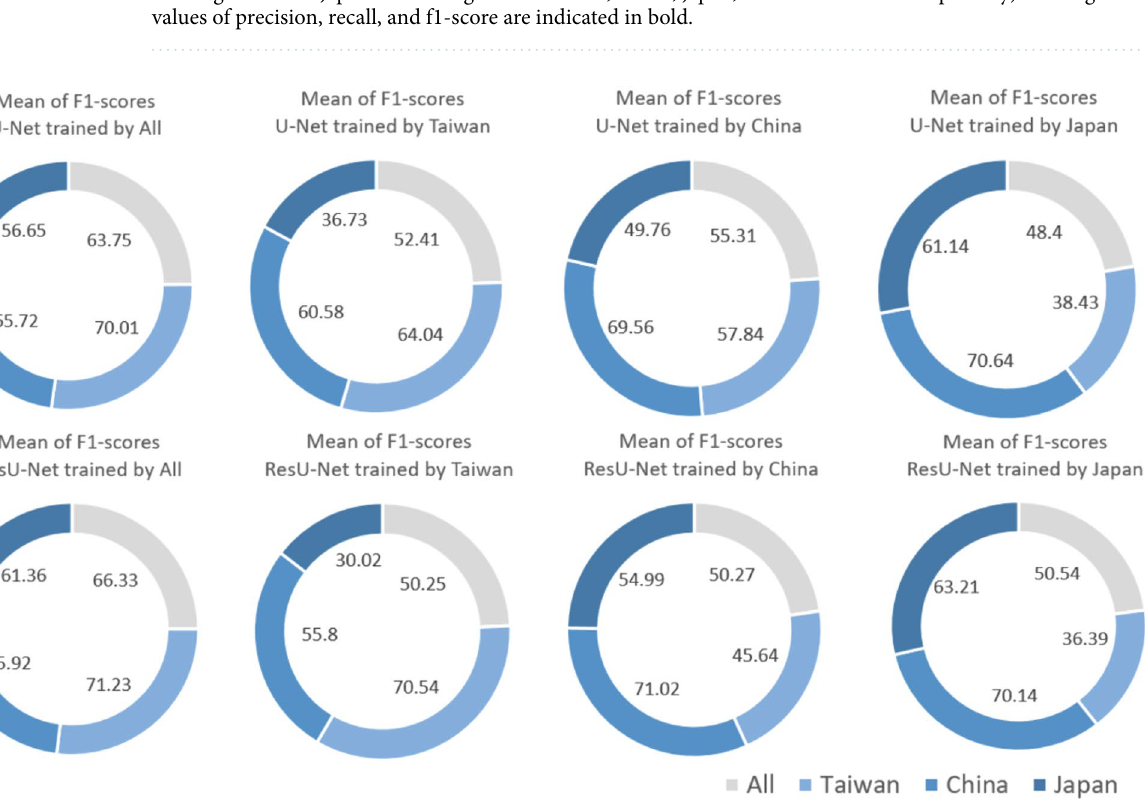
Figure 10. Overall mean F1-score values for U-Net and ResU-Net in relation to each of the four original